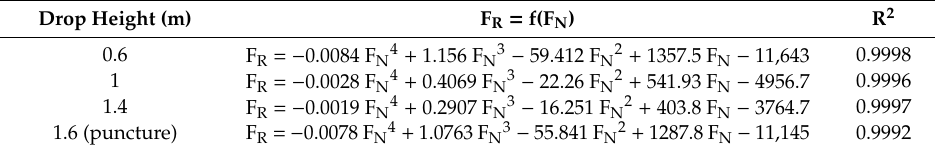
Table 9. Correlation between the impact force F R and the tensile force F N for the drop hammer weight of 90 kg.